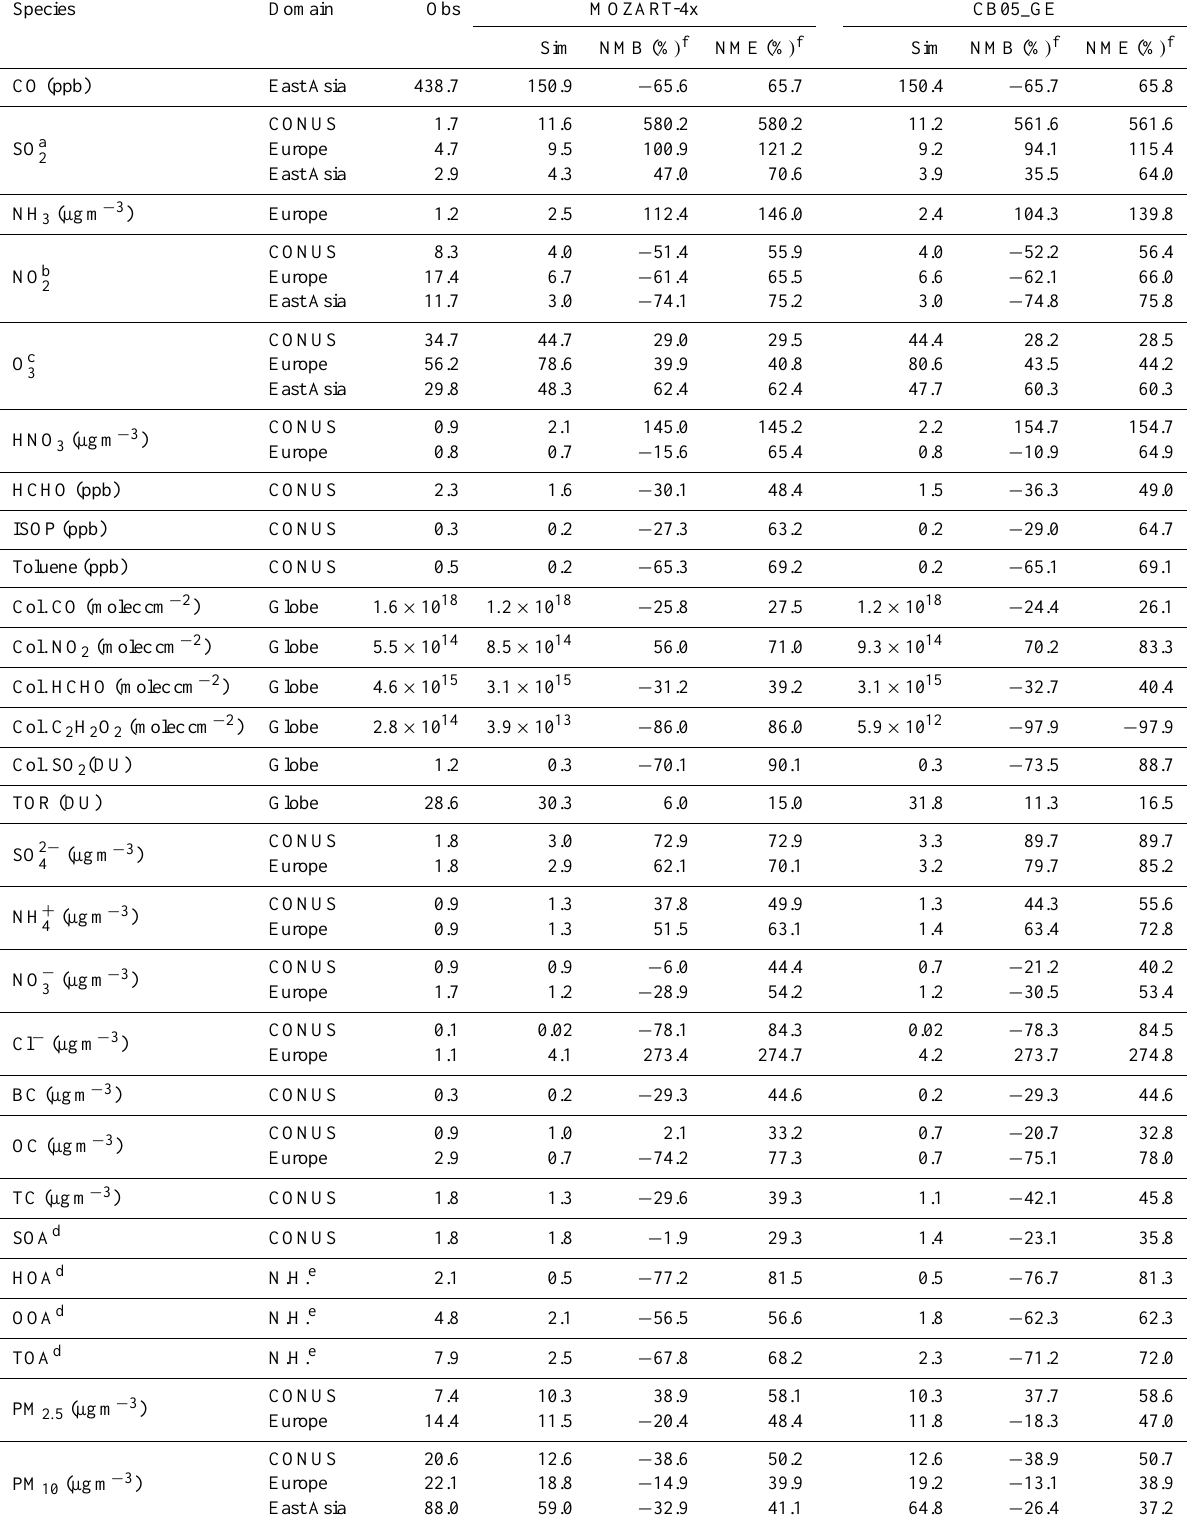
Table 3. Performance statistics of chemical